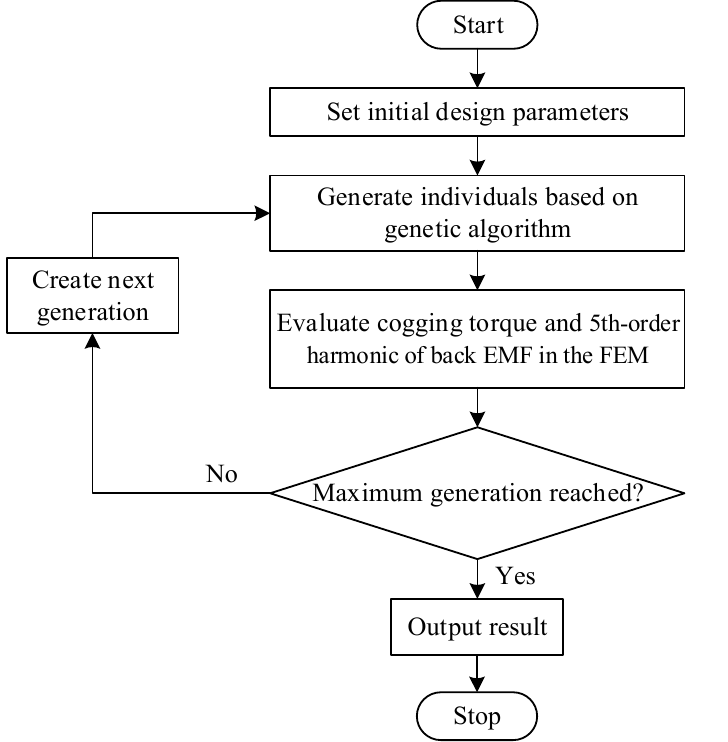
Figure 8. Flowchart of the optimization process.